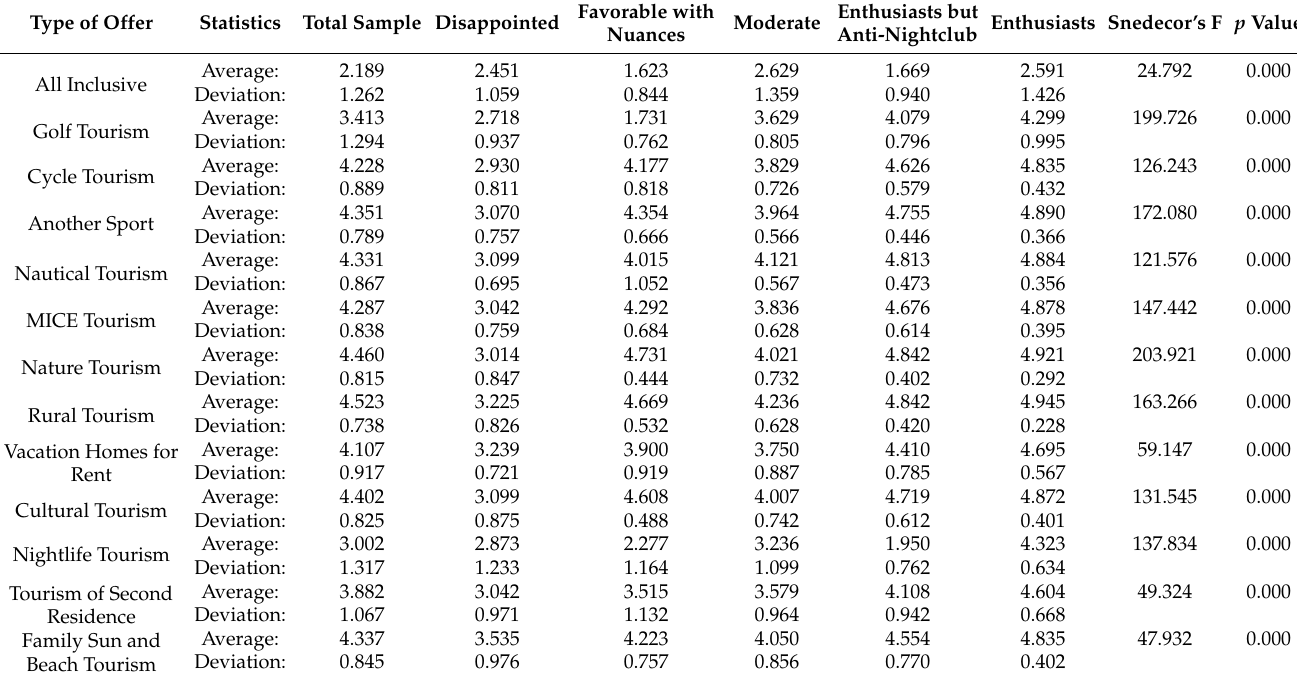
Table 3. Average values of the conserved clusters (own